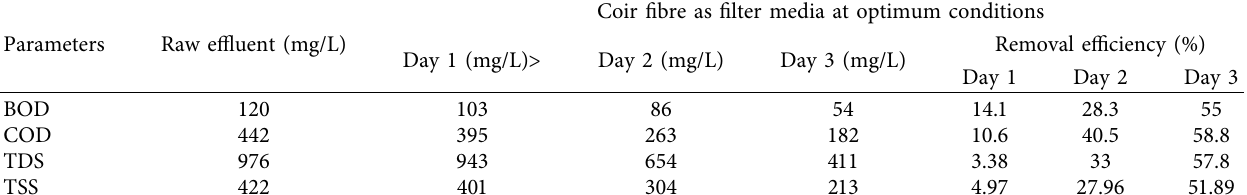
Table 2: The removal efficiency of wastewater using Coir fibre as filter media.